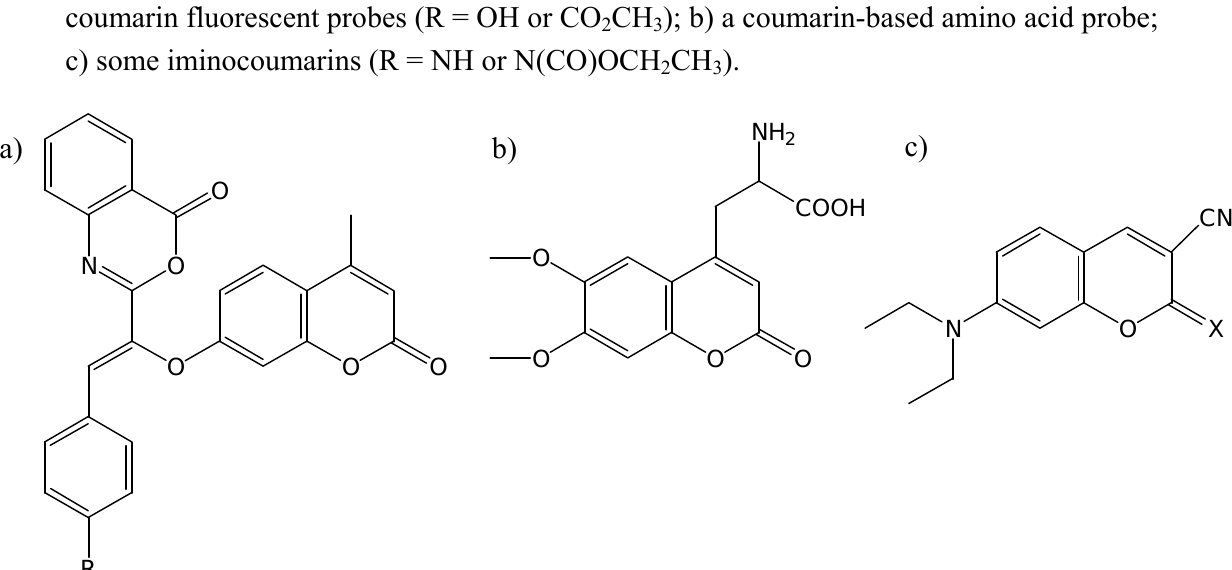
Figure 4 . The chemical structure of a) a pair of specifically-designed viscosity-dependent coumarin fluorescent probes (R = OH or CO